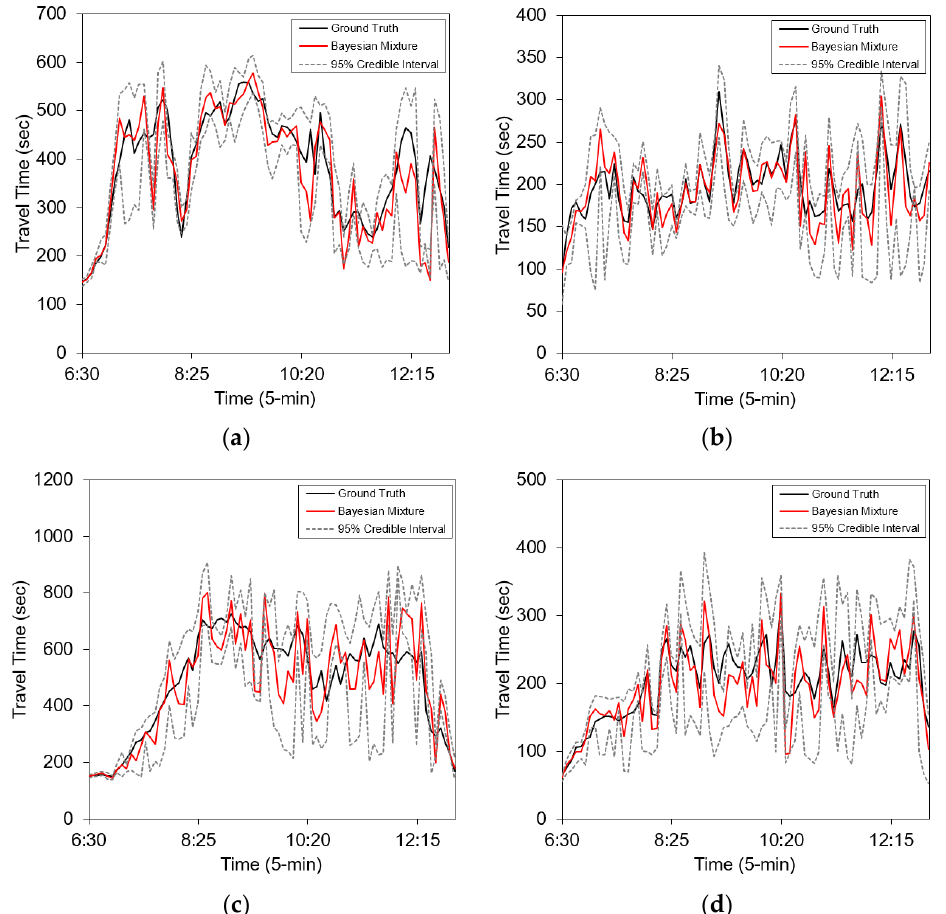
Figure 4. The credible intervals of the estimated travel time on: ( a ) Case I, 29 April 2017, ( b ) Case II, 29 April 2017, ( c ) Case I, 5 May 2017, ( d ) Case II, 5 May 2017.